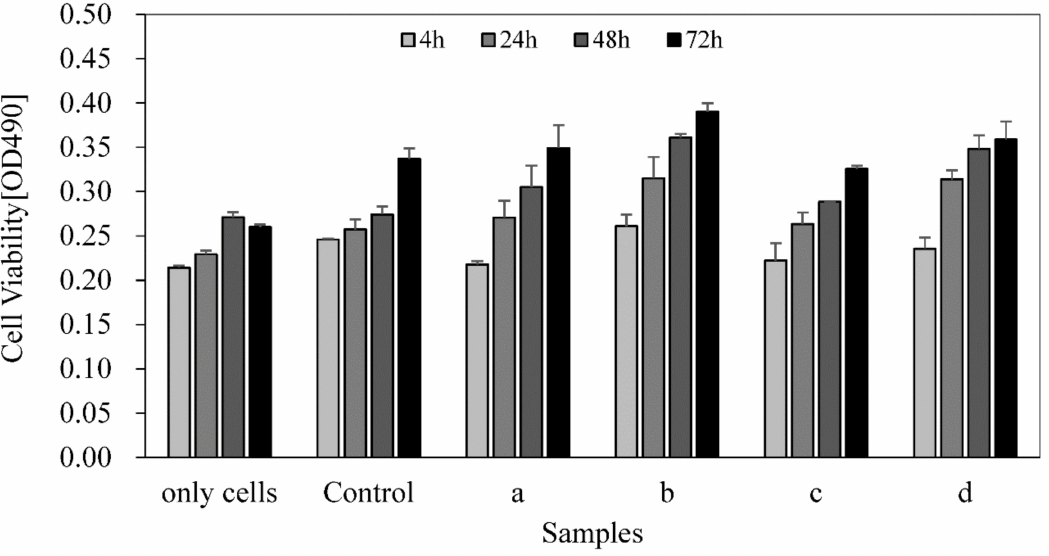
Figure 8. Cell viability was tested after obtaining the medium eluted from the (human keratinocyte cell line, HaCaT cells); only cells, control sponge, ( a ) Alg-CMC ratio (5:5); ( b ) Alg-CMC ratio (5:5) with dextran; ( c ) Alg-CMC ratio (7:3); ( d ) Alg-CMC ratio (7:3) with dextran (MTS assay, n = 3, mean ±